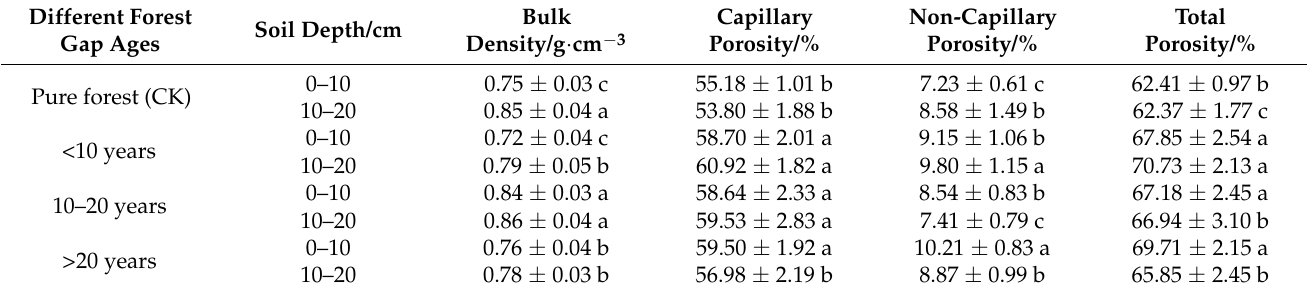
Table 2. Soil bulk density and porosity characteristics in forest gap of different ages.